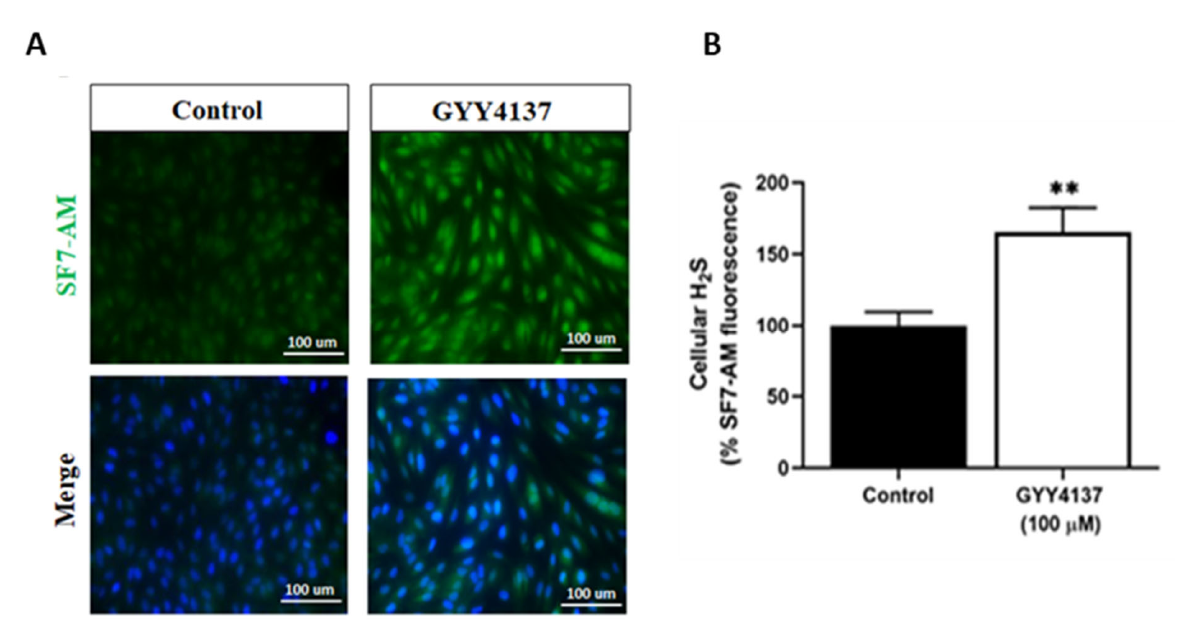
Figure 1. GYY4137 induces H 2 S in HUVECs. ( A ) Intracellular H 2 S content in HUVECs was evaluated by double staining with SF7-AM (an H 2 S marker, green) and DAPI (a nuclei marker, blue). Scale bar 100 µ m. ( B ) Quantification of fluorescence intensity in GYY4137-treated cells relative to untreated HUVECs (control). A total of 100 cells per field in each group per independent experiment were analysed using DAPI staining, and SF7-AM fluorescence intensity was measured. p -values were calculated using the unpaired Student t -test. Data are shown as means ± SD; ** p < 0.01 vs. control, (n = 3).